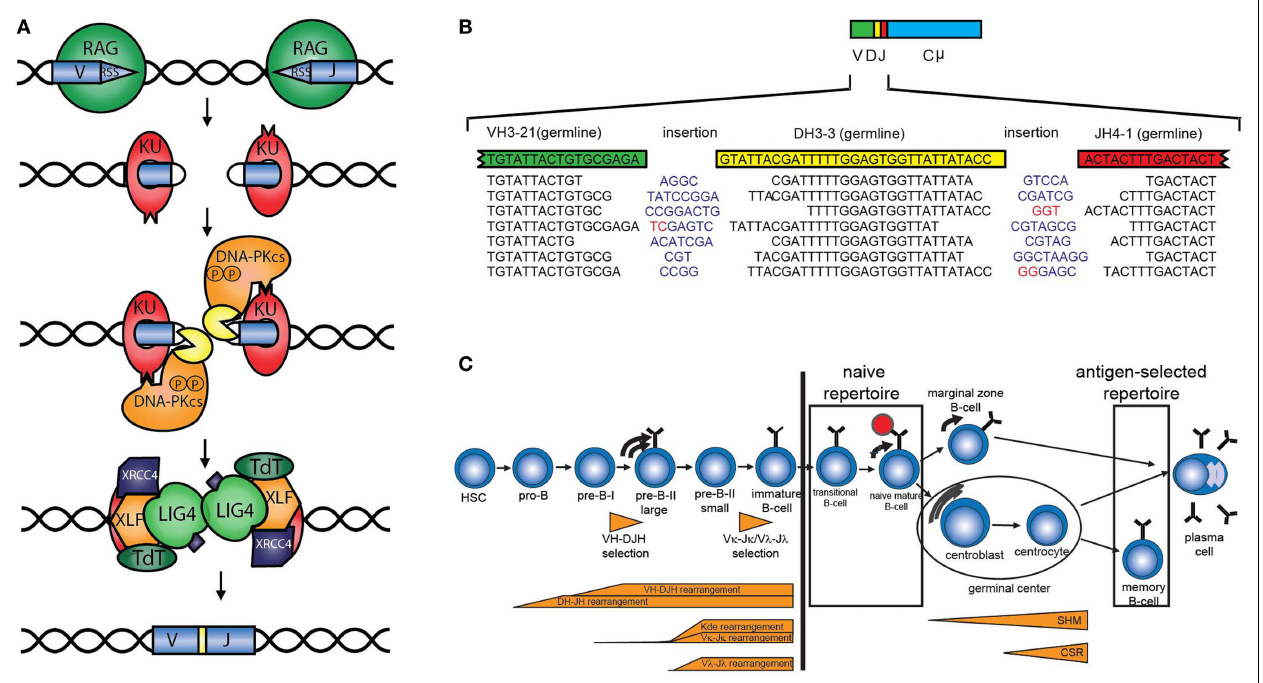
FIGURE 1 |V(D)J recombination and B-cell development . (A) Schematic overview ofV(D)J recombination. DNA double strand breaks are introduced by the RAG proteins, subsequently the DNA is processed and ligated by DNA repair proteins from the NHEJ pathway. (B) Examples ofV(D)J junctions